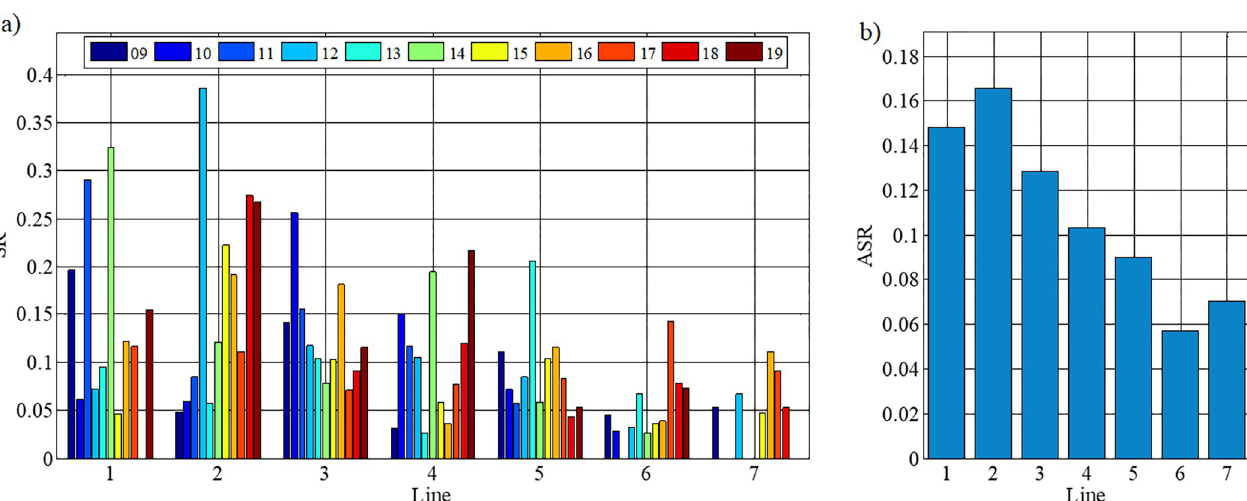
PLOS ONE | https://doi.org/10.1371/journal.pone.0271340 July 26,